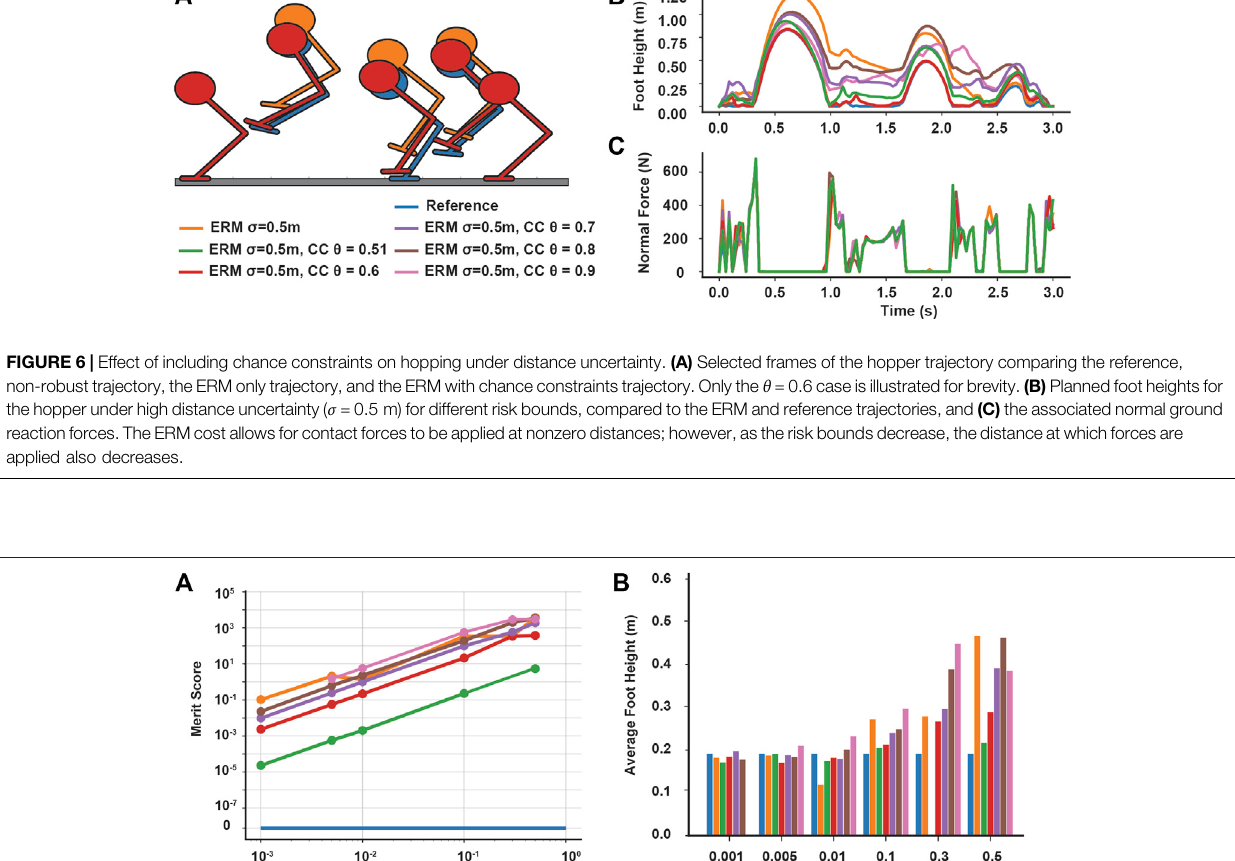
Frontiers in Robotics and AI |